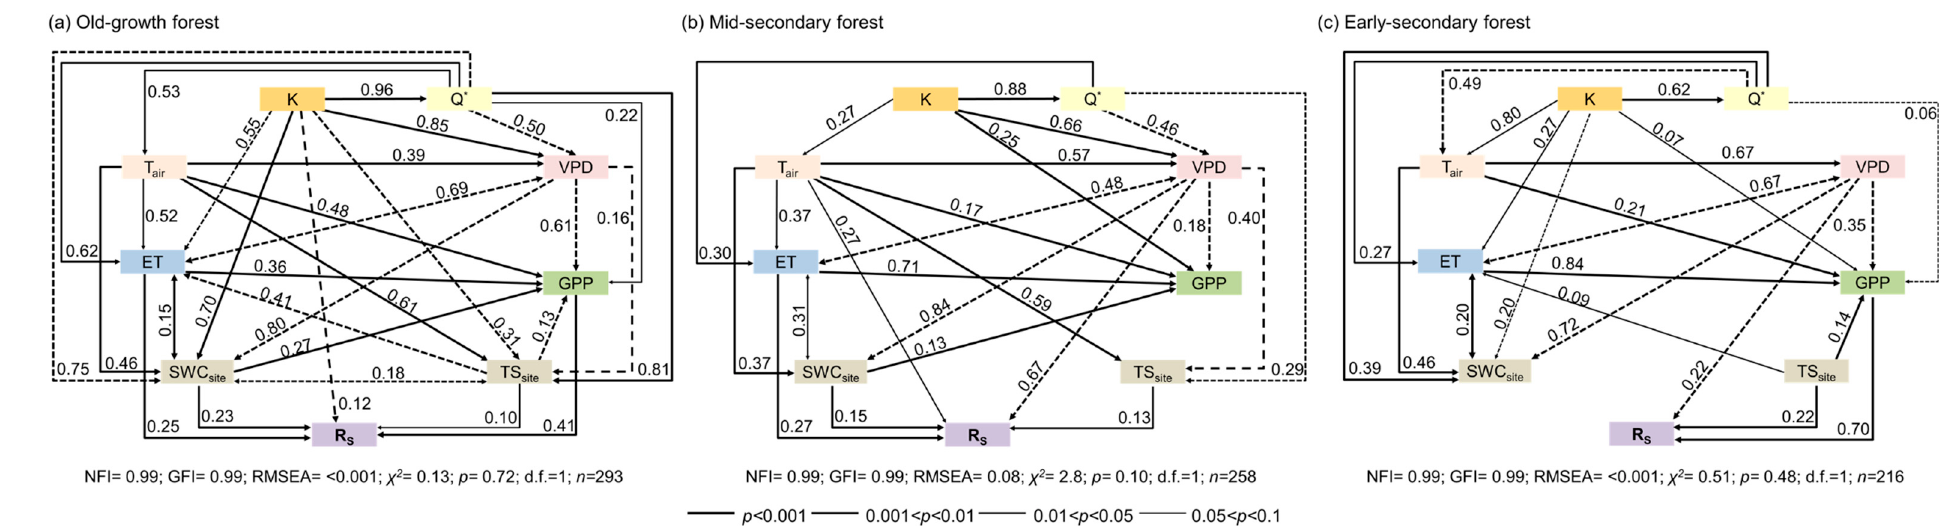
Figure 2. Structural equation models along forest succession in a tropical dry forest from northwestern Mexico. The model illustrates hypothesized direct and indirect relationships of biophysical controls over R S on an old-growth ( a ), mid-secondary ( b ) and early-secondary ( c ) tropical dry forest. The path diagrams depict the positive (solid lines) and negative (dashed lines) effects with their standardized regression weights (SRW). Each site path diagram shows the Bentler and Bonett’s normed-fit index (NFI), the goodness-of-fit index (GFI), the root-mean-square error of approximation statistic (RMSEA), a Chi-square ( χ 2 ) value, the significance probability of p -value, the degrees of freedom (d.f.) and sample size ( n ). Arrow widths are proportional to p -value scheme.